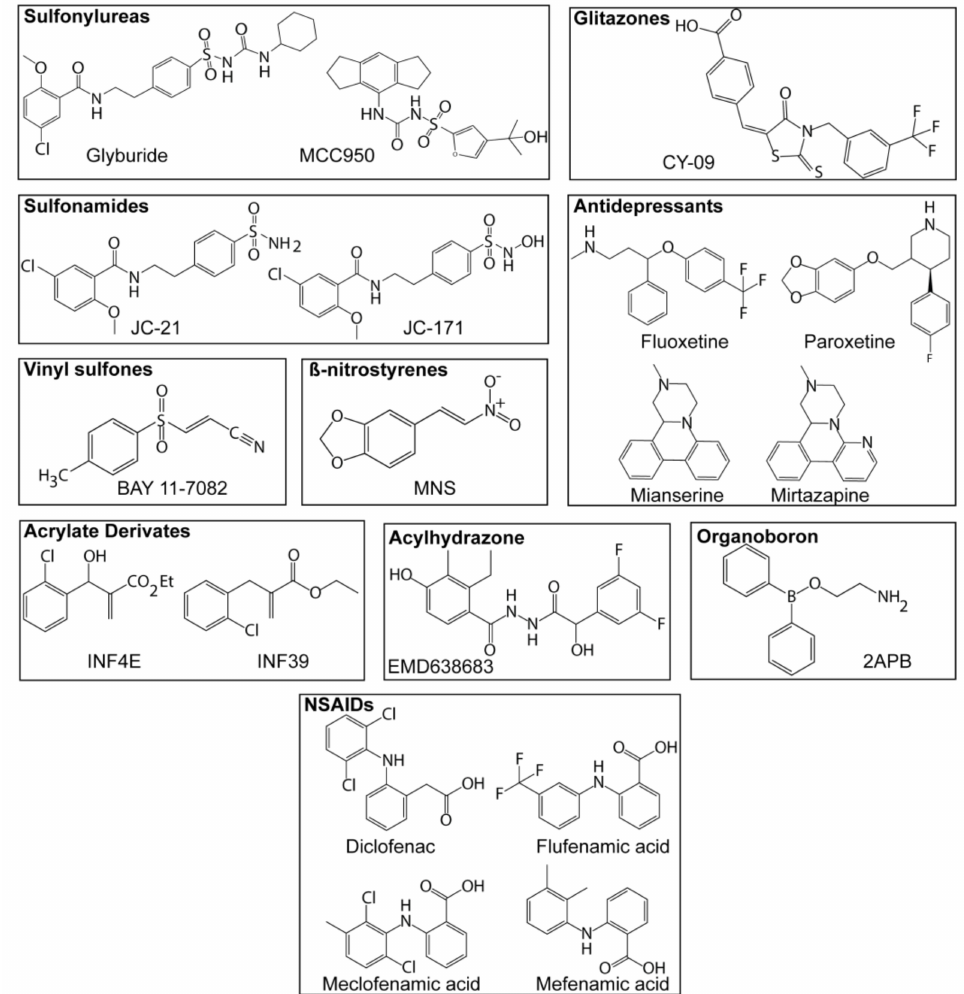
Figure 5. Chemical structure of different NLRP3 inflammasome inhibitors. Chemical structure of different sulfonylureas, sulfonamides, vinylsulfones, β -nitrostyrenes, acrylate derivates, glitazones, antidepressants, acylhydrazones, organoboron, and nonsteroidal anti-inflammatory drugs (NSAIDs) with proven activity as NLRP3 inflammasome